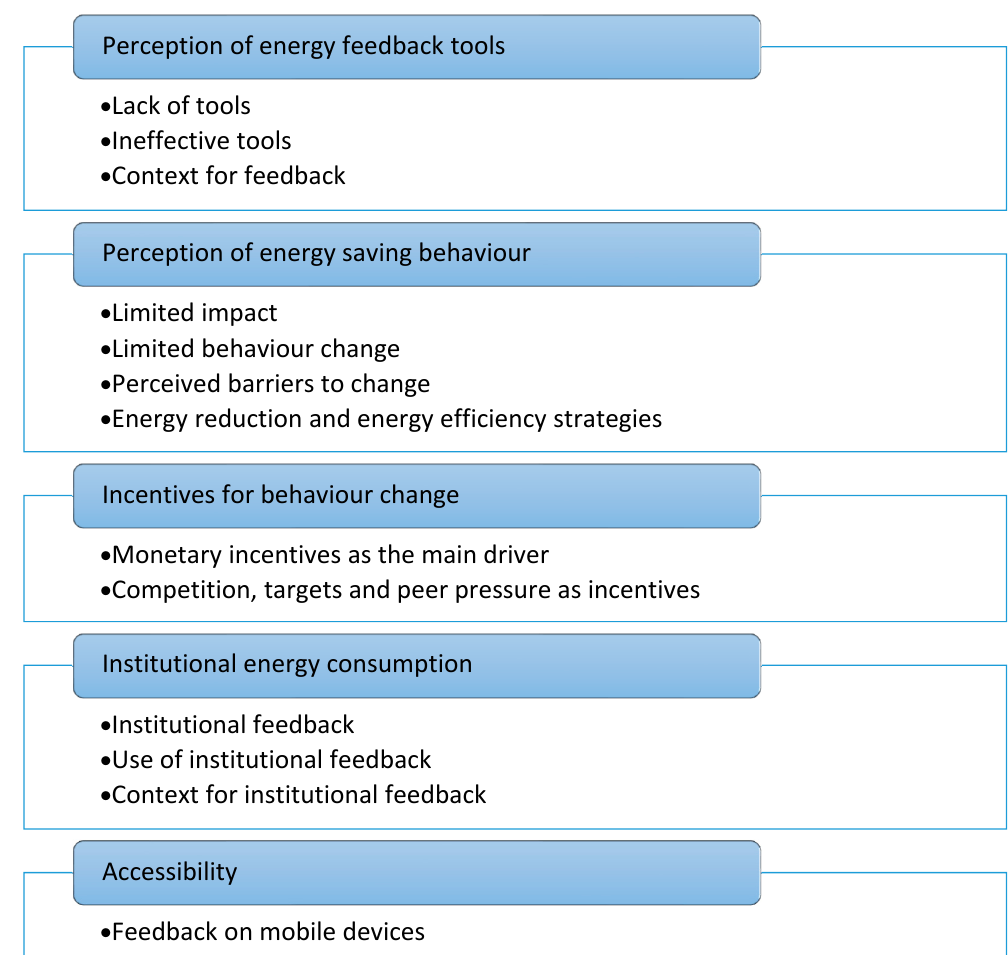
Figure 1. The five key energy feedback perception themes and sub-themes extracted from the coding of participant feedback.